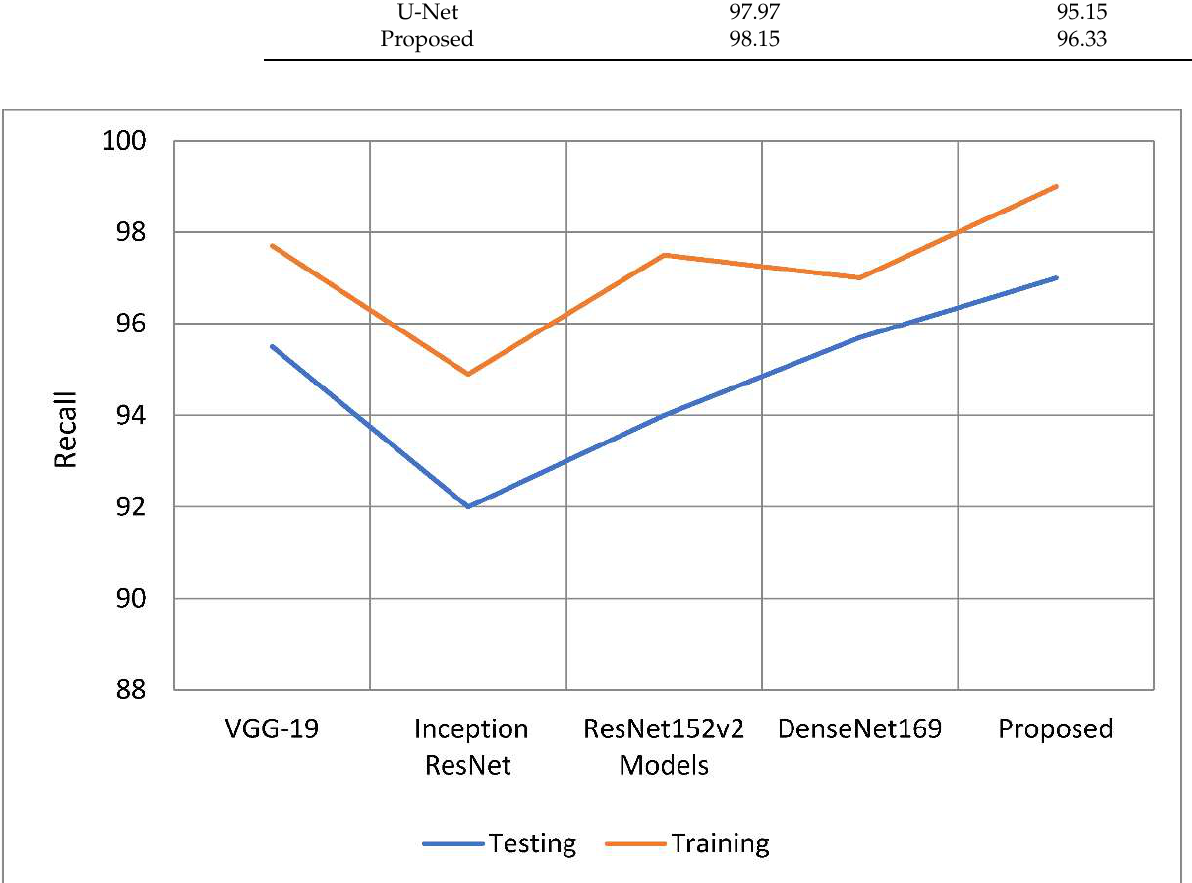
Figure 10. A comparative analysis of recall of the proposed model with traditional models.